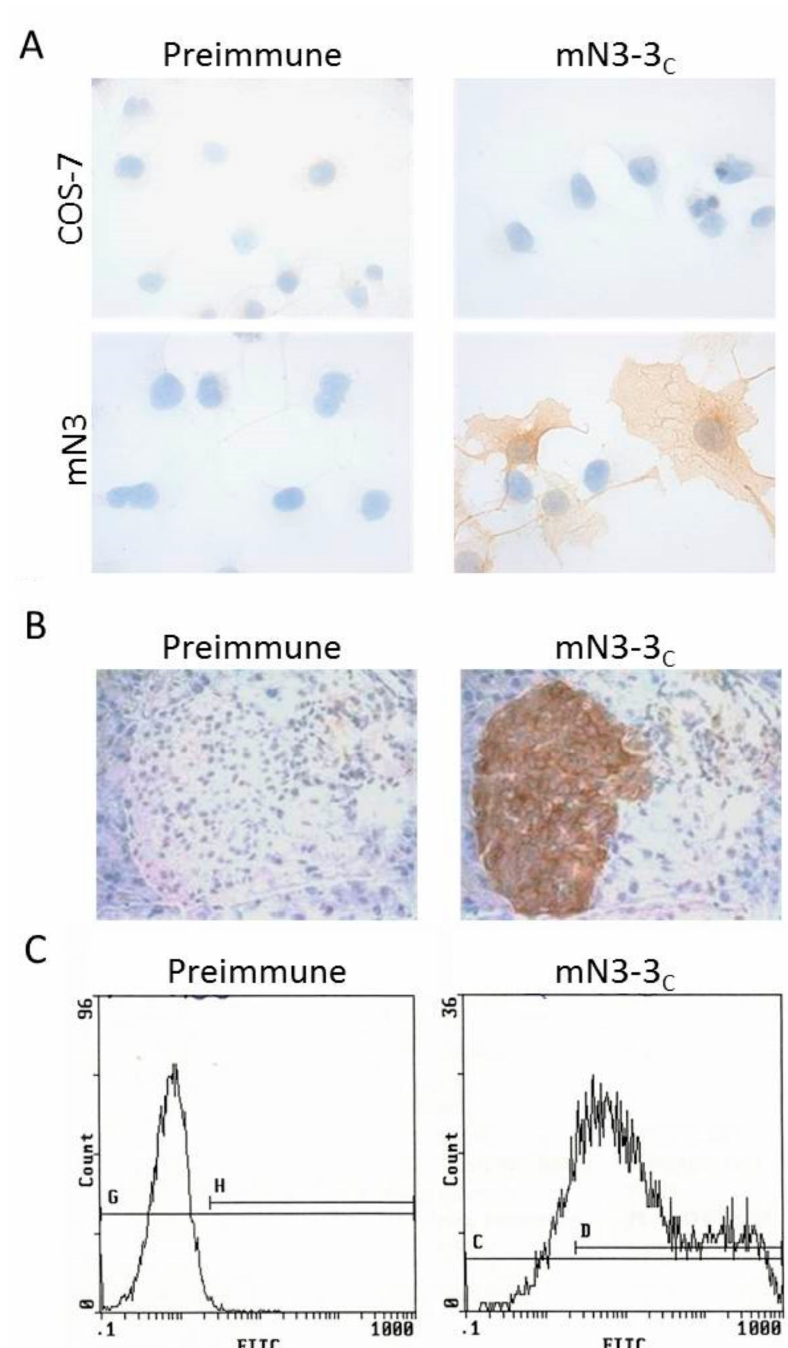
Figure 2. Specificity of the guinea pig anti-mouse NTPDase3 antibody mN3-3 c . ( A ) Strong signals in immunocytochemistry of transfected COS-7 cells with a plasmid encoding mouse NTPDase3 (mN3) are only detected with antiserum mN3-3 c (rabbit “12” in Figure 1D). No signals are detected with the pre-immune serum or with the anti-serum on un-transfected cells (COS-7). ( B ) Immuno- histochemistry of serial sections from a mouse pancreas. The antiserum displays a positive reaction on the cells of the Langerhans islets. ( C ) Flow cytometry of transfected HEK 293T cells with a plasmid encoding mouse NTPDase3 shows a rightward shift (right panel) when compared to its pre-immune control (left panel). Nuclei were stained in blue with hematoxylin ( A , B